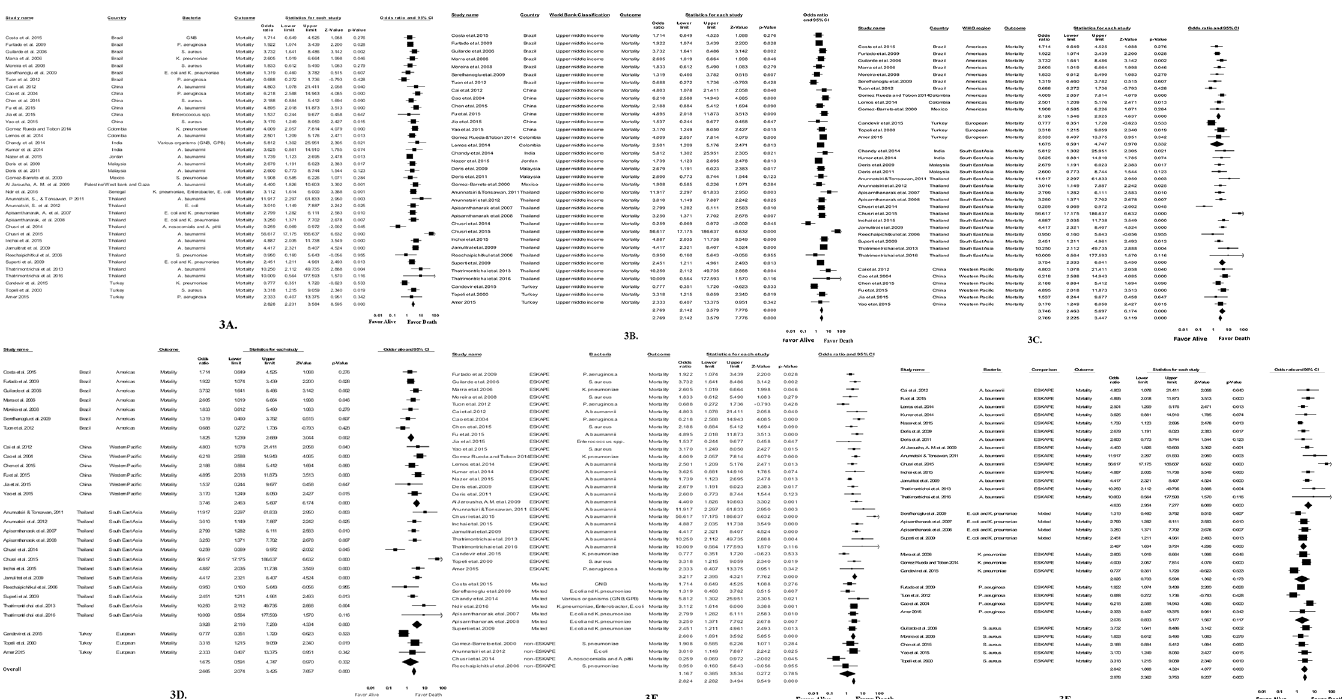
Fig 3. Forest plot of impact of ABR on mortality and sub-group analyses per World Bank classification, WHO regions, countries, group of bacteria and bacteria species. 3A. Forest plot of overallimpact of antibiotic-resistance on mortality in includedstudies. 3B. Forest plot of impact of ABR on mortality analyzedper World Bank Classification. 3C. Forest plot of impact of ABR on mortality analyzedper WHO regions. 3D. Forest plot of impact of ABR on mortality analyzedper countries. 3E. Forest plot of impact of AMR on mortality analyzedper group of bacteria. 3F. Forest plot of impact of ABR on mortality analyzedper bacterial